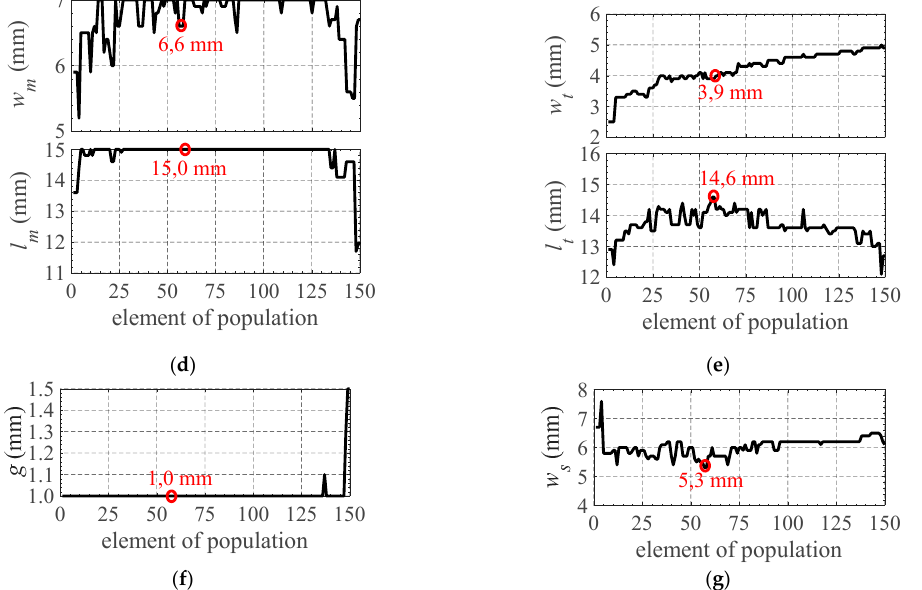
Figure 12. Pareto front—Objective functions and decision variables. In each figure is shown the evolution, for each element of population, of ( a ) the torque, T , and e ffi ciency, η , ( b ) the torque producing current density, J oq , ( c ) the rotor and shaft radius, r r and r s , ( d ) the magnet width and length, w m and l m , ( e ) the teeth width and length, w t and l t , ( f ) the airgap size, g , and ( g ) the stator outer ring width, w s